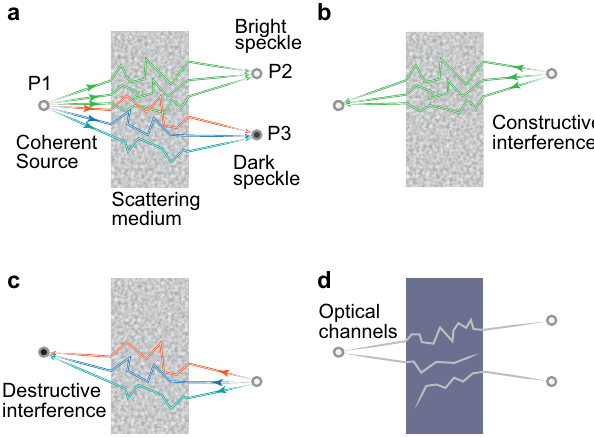
Fig. 1 Optical intensity channels. a A coherent source or Guidestar at position P1 on the input plane leads to a bright speckle at position P2 and a dark speckle at position P3 on the target plane. In the case of a bright speckle, the majority of the optical paths share a similar phase (denoted by the same color) and thus relatively constructively interfere. In contrast, the optical paths leading to the dark speckle are out of phase (denoted by different colors). b , c Based on the time-reversal symmetry of optical propagation, a bright speckle at position P2 will also lead to a bright speckle at position P1 ( b ). However, a bright speckle at position P3 will not result in a bright speckle at position P1 due to destructive interference ( c ). d This phenomenon is interpreted in a picture of optical channels. A ‘ bright ’ optical channel is established between position P1 and P2 for optical energy transmission while the optical channel between position P1 and P3 is ‘ dark ’